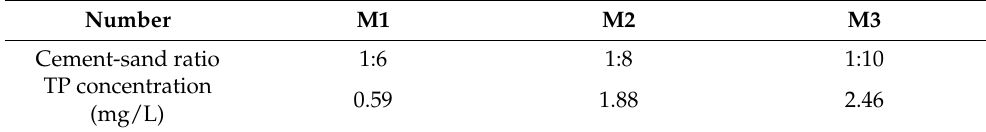
Table 2. TP concentrations in leachate from PGB bodies under different cement-sand